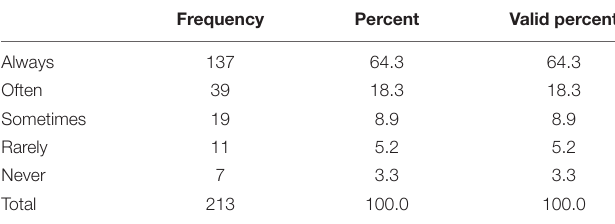
TABLE 3 | I deliver my verbal requests to other members in English.